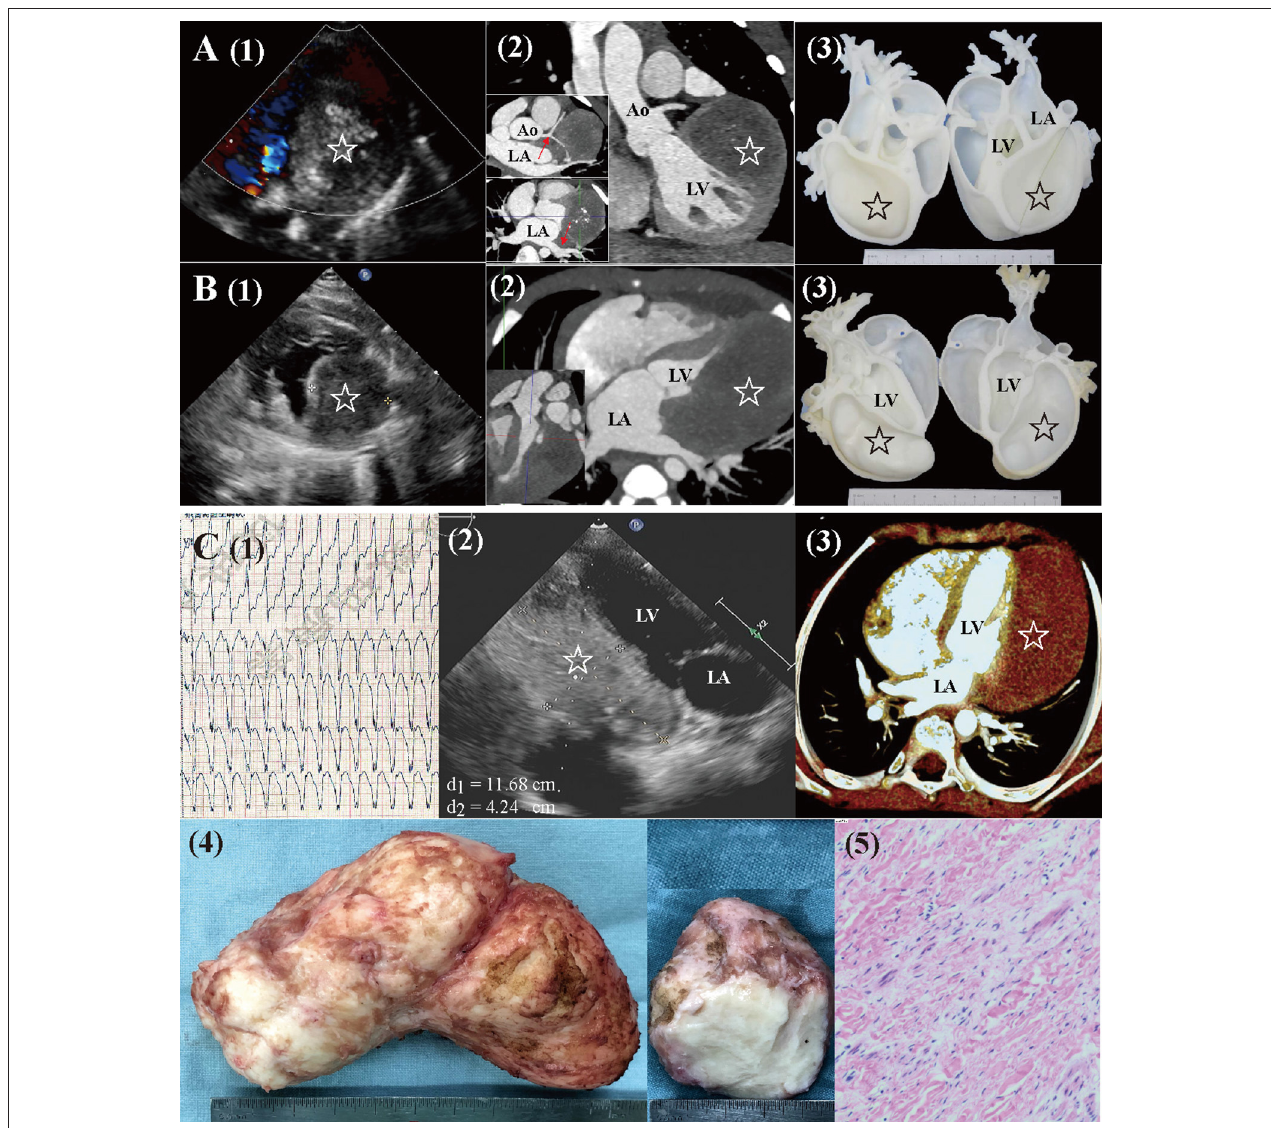
FIGURE 1 | Preoperative workups and surgical resection of large cardiac fibromas. (A) Echocardiography, CTA, and 3D-printed models for a 4.2-year-old female. The mass (star) extended close to the left coronary artery and left pulmonary veins [red arrow in (2)], with visible calcification. (B) Echocardiography, CTA, and 3D-printed models for a 6-month-old male. The mass (star) extended from the base to the apex, with a distinctly larger volume than that of LV. (C) A 7.5-year-old male (1) presented with sustained ventricular tachycardia (176 bpm). (2, 3) Echocardiography and CTA revealed a huge mass (star. length: 12cm, volume: 213ml, and volume index: 227 ml/m 2 ) located at LV posterolateral wall. (4, 5) Gross specimen and histologic examination of the mass, typical of fibroma. Ao, aorta; CTA, computed tomography angiography; LA, left atria; LV, left